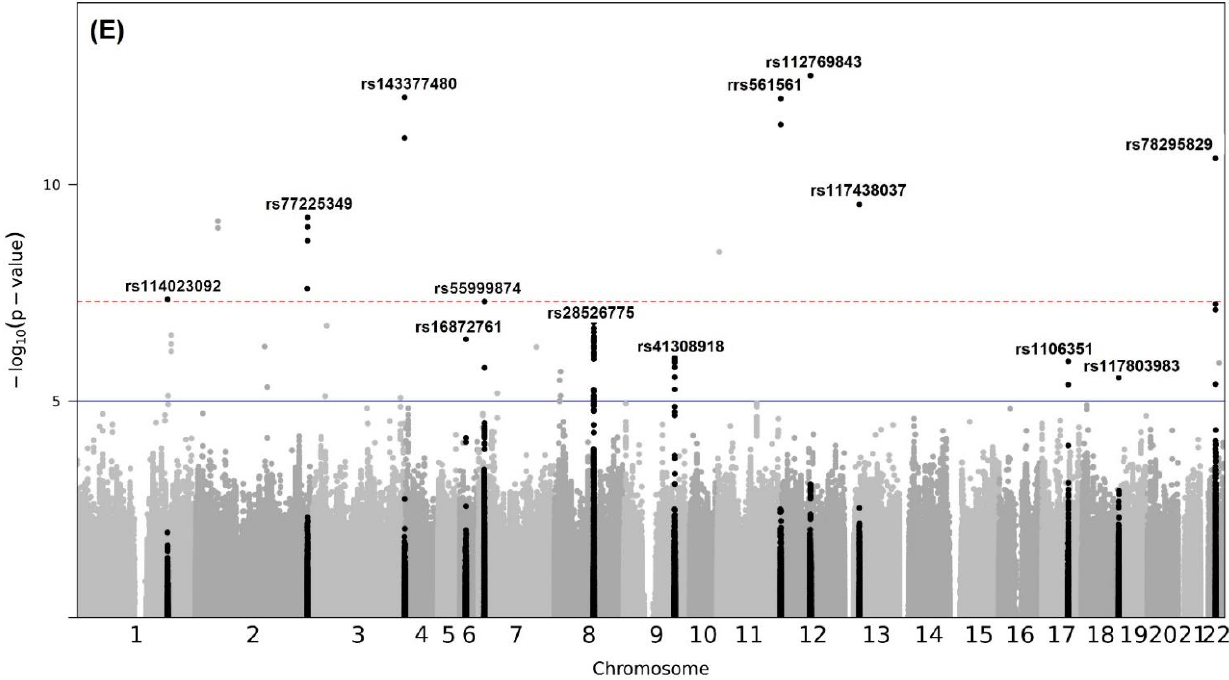
Figure 3. Manhattan plots of combined GWASs performed on skin phenotype. We performed genetic variation analysis of ( A ) wrinkles, ( B ) moisture content, ( C ) pigmentation, ( D ) oil contents, and ( E ) sensitivity. The results for each skin phenotype are represented in a Manhattan plot. In the plots, the x-axis represents the chromosome number; the y-axis represents the results of GWAS; the blue indicates 1.0 × 10 − 5 , and the red line indicates 5.0 × 10 − 8 based on the p -value.